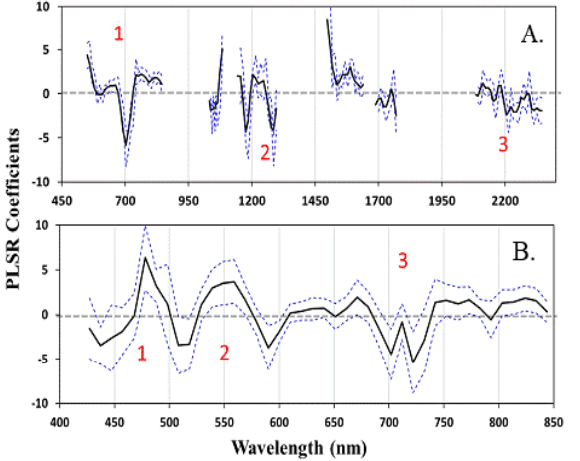
Figure 6. Standardized PLSR coefficients (means solid line, SD dashed lines) for GPP derived using Hyperion (A.) and the combined Hyperion VNIR and DESIS convolved to Hyperion (B.) reflectance datasets. The spectral regions of importance for the predictions are numbered.